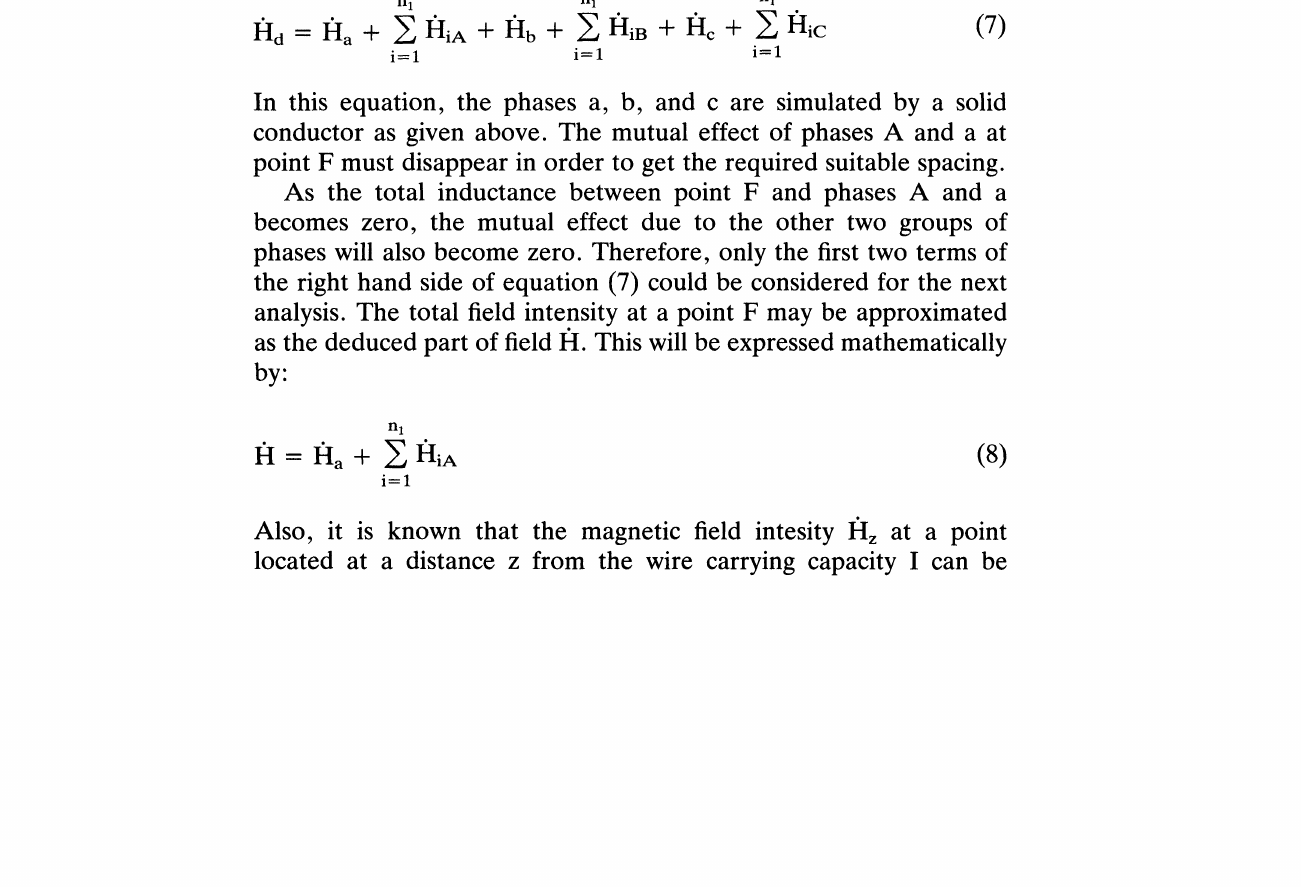
FIGURE 5 The distribution of current ratio along the line at a no load operation based on ref